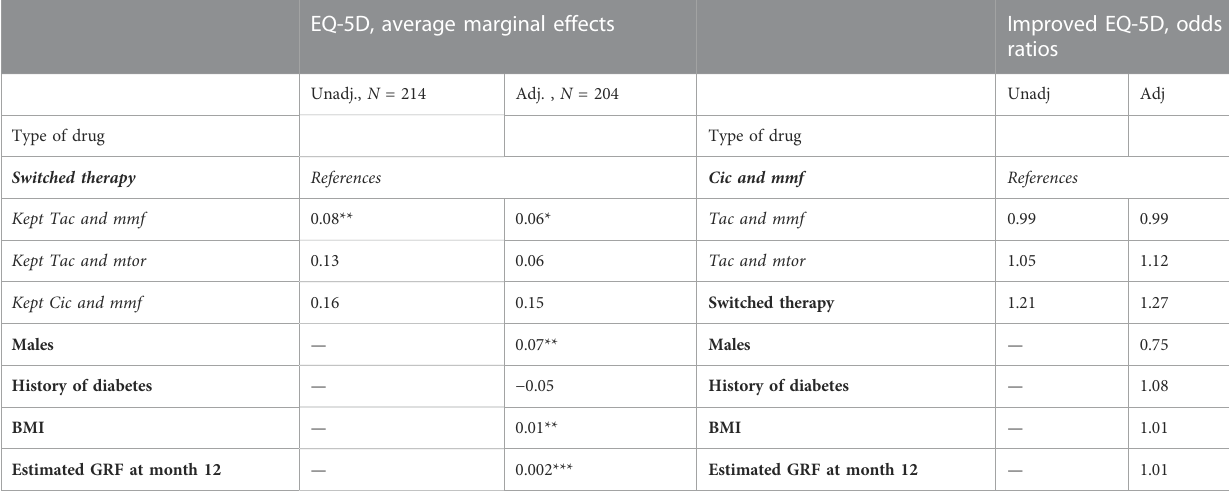
TABLE 2 EQ-5D at closing visit M12 and improvement of EQ-5D over the whole observation period.